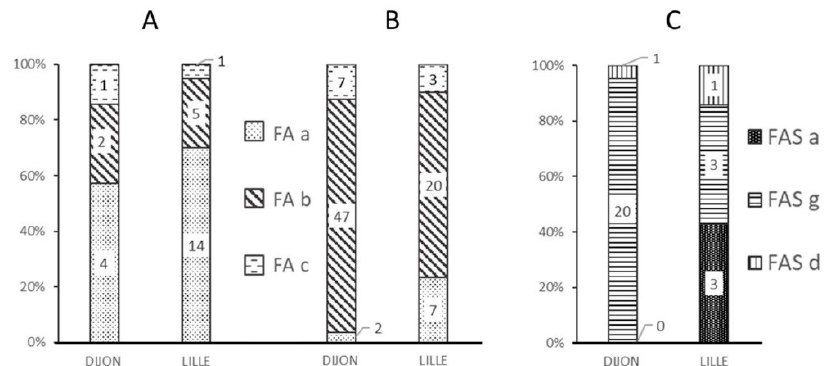
Figure 1. Frequency of the different alerts (FA-a, FA-b, FA-c, FAS-a, FAS-g, and FAS-d) at each analytical facility and as a function of each spectrum’s MALDI-MS classification. ( A ) Alerts for “standard” MALDI FA spectra; ( B ) Alerts for “non-standard” MALDI FA spectra; ( C ) Alerts for misclassified “non-standard” MALDI spectra.